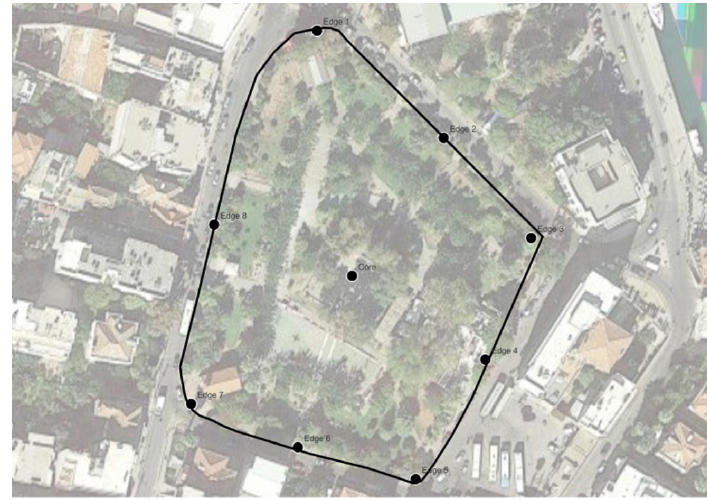
Figure 3. Example of sampling check points for CUQI extraction.